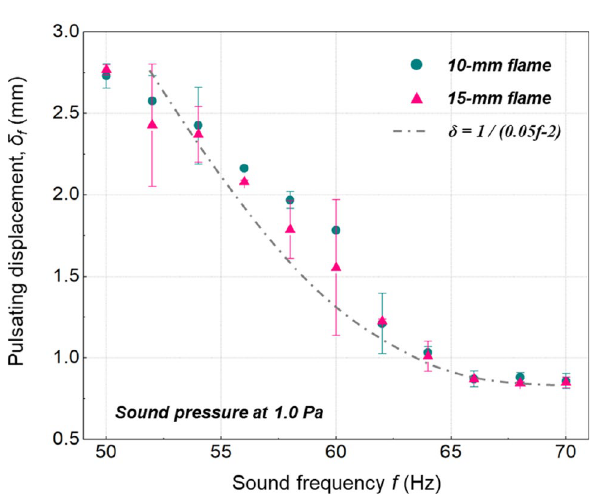
Figure 6. Dependence of flame pulsating displacement on sound pressure for ( a ) 10-mm and ( b ) 15-mm flames under different sound frequencies, where the error bar shows the uncertainty of repeating tests.